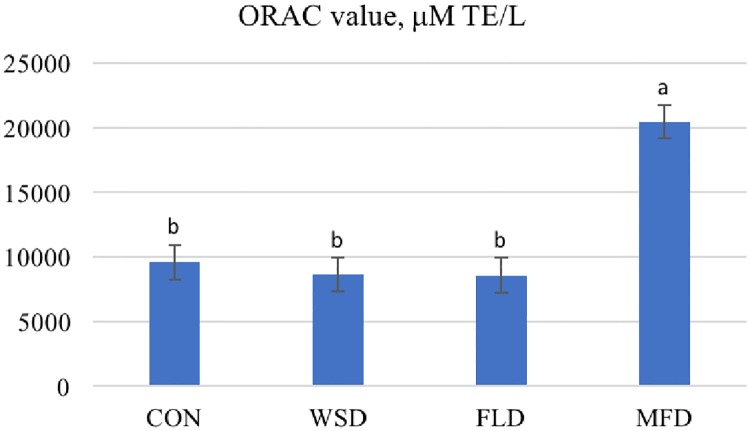
Five-point fecal scoring chart used to score feces of dog fed control (CON), whole sorghum (WSD), sorghum flour (FLD) and sorghum mill-feed (MFD) diets.